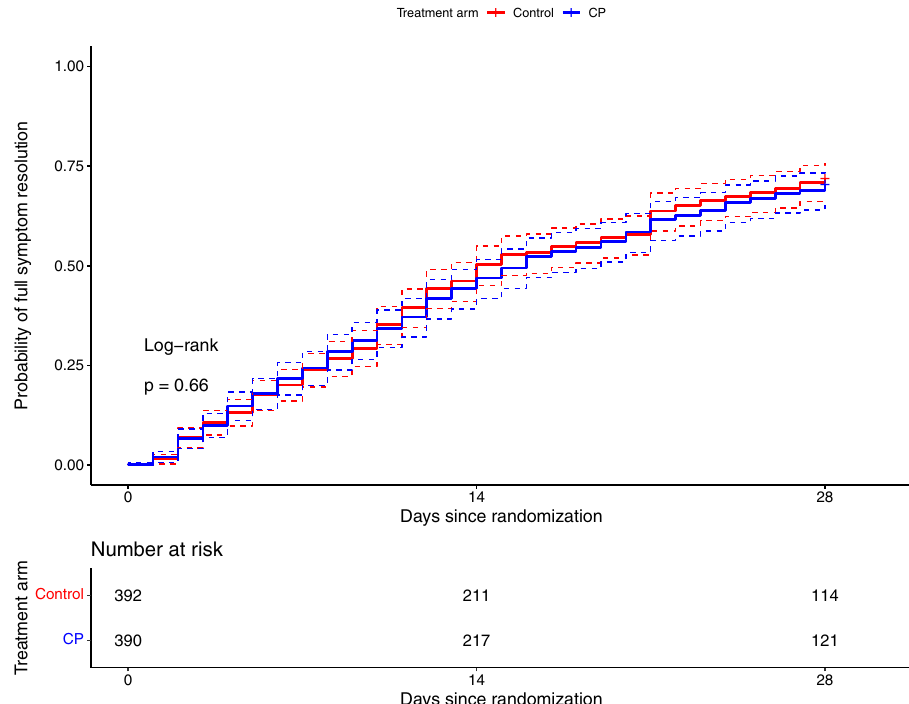
Fig. 3 Time to full symptom resolution up to day 28 (end of follow-up). CP Convalescent plasma. Log-rank test p = 0.66. The dotted error bars represent the 95% CI.